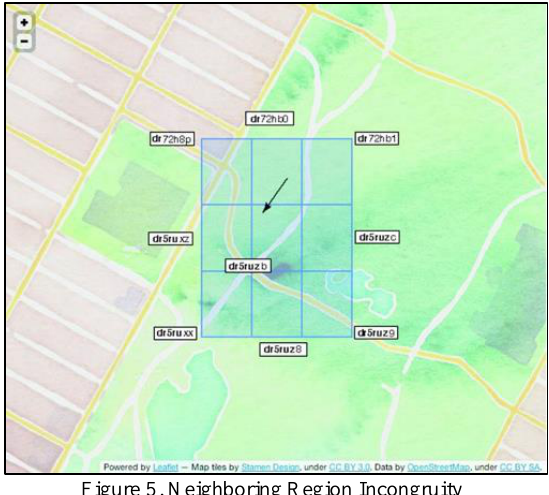
Figure 5. Neighboring Region